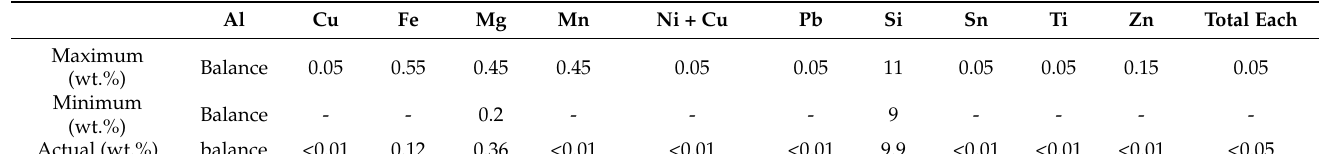
Table 1. Chemical composition of the used powder [16].